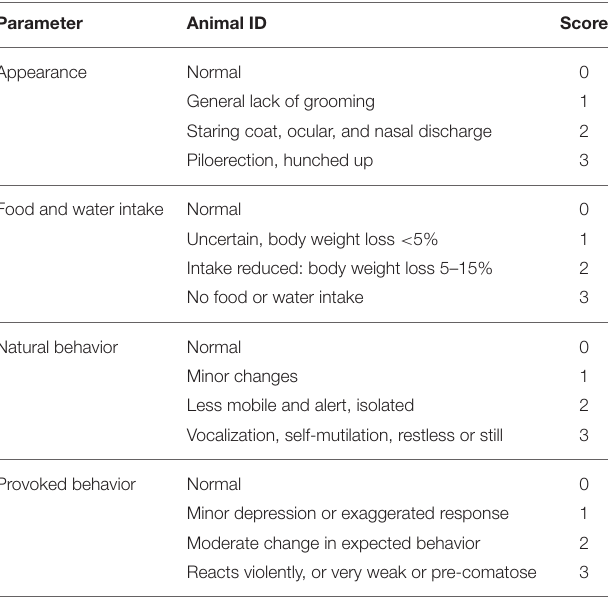
TABLE 4 | Scoresheet used to assess the impact on the health and behavior of experimentally treated mice. Parameter Animal ID Score Appearance Normal 0 General lack of grooming 1 Staring coat, ocular, and nasal discharge 2 Piloerection, hunched up 3 Food and water intake Normal 0 Uncertain, body weight loss < 5% 1 Intake reduced: body weight loss 5–15% 2